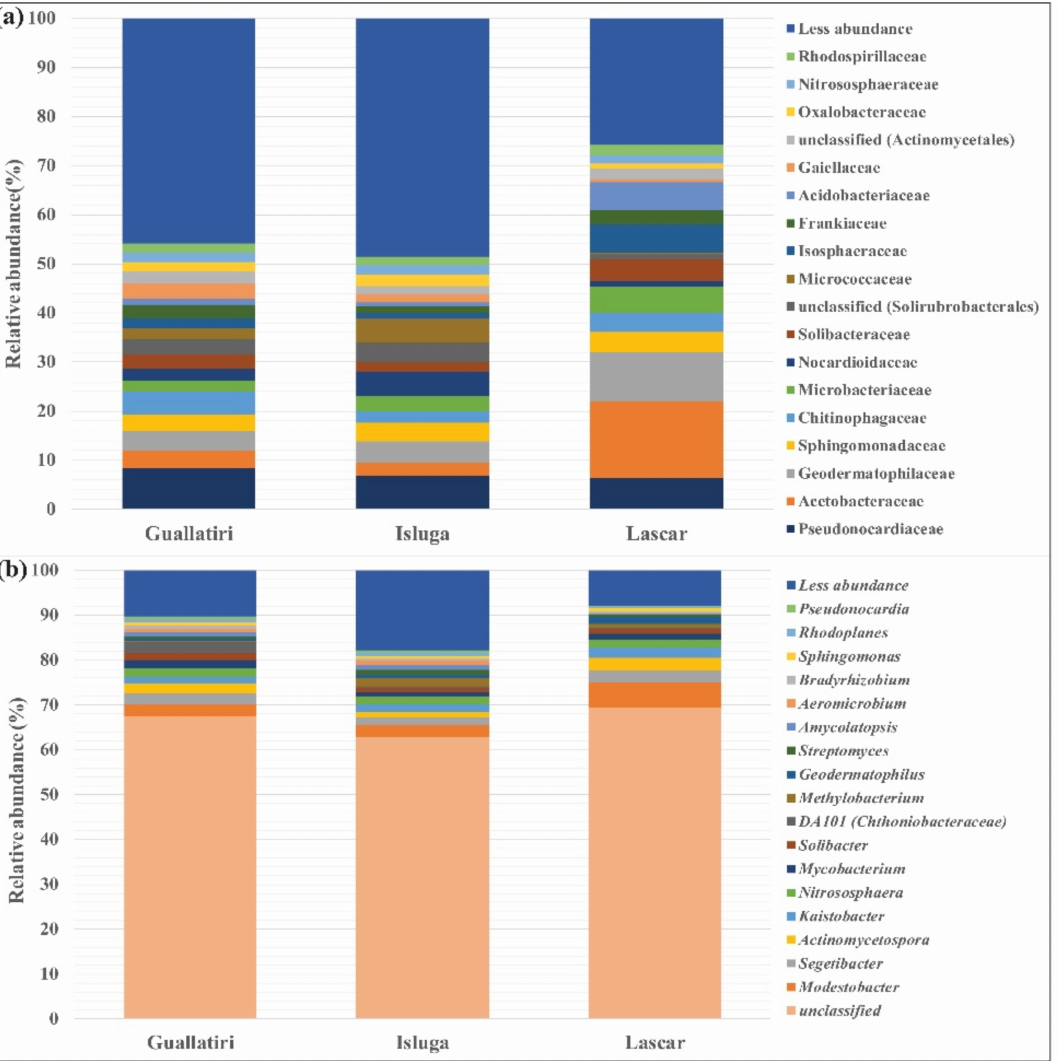
Figure 3. Mean relative abundances of family ( a ) and genus ( b ) level taxa in total rhizobacterial communities from P. quadragularis grown at the Guallatiri, Isluga, and Lascar volcano